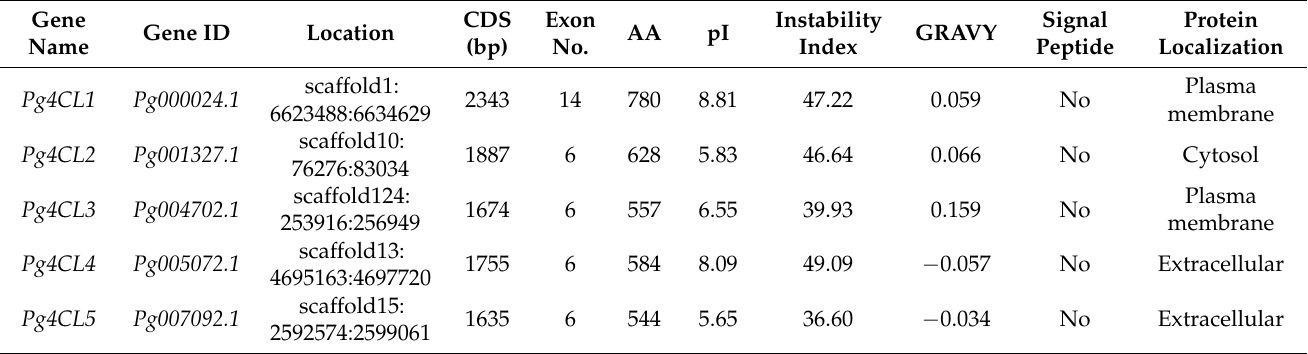
Table 1. The basic information of the Pg4CLs gene family in the